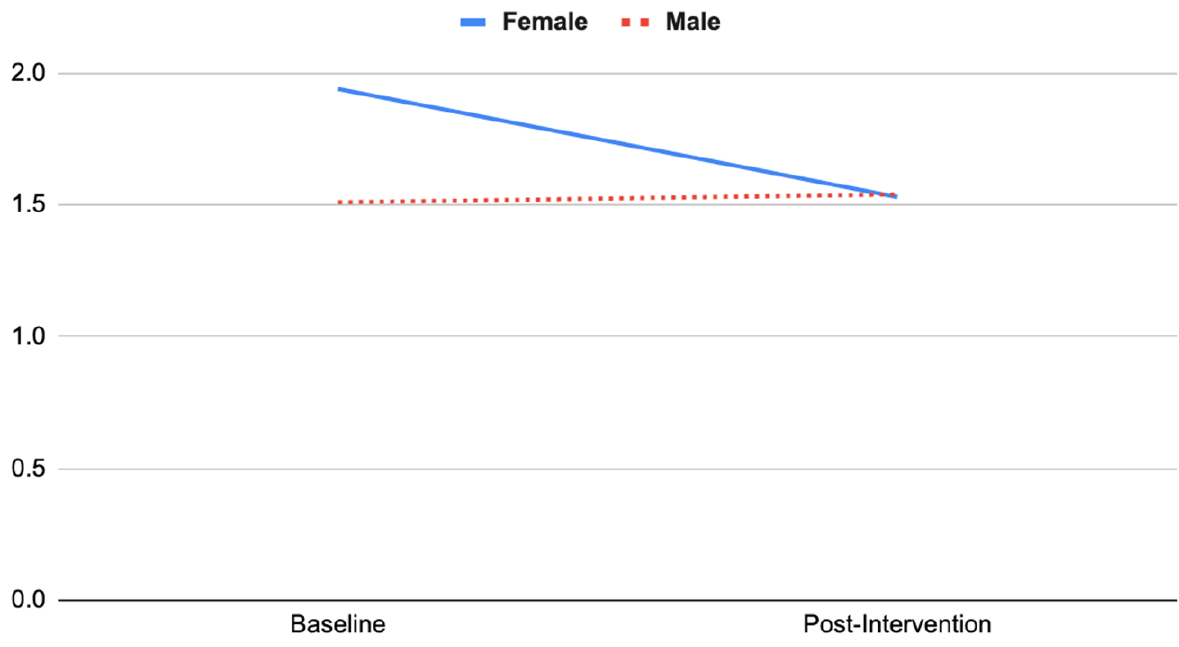
Figure 1. Interaction effect between gender and anxiety.